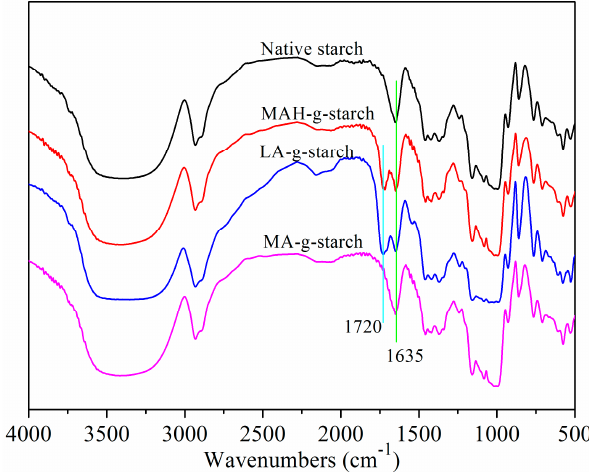
Figure 2. Infrared spectrum of native starch and grafted starches.